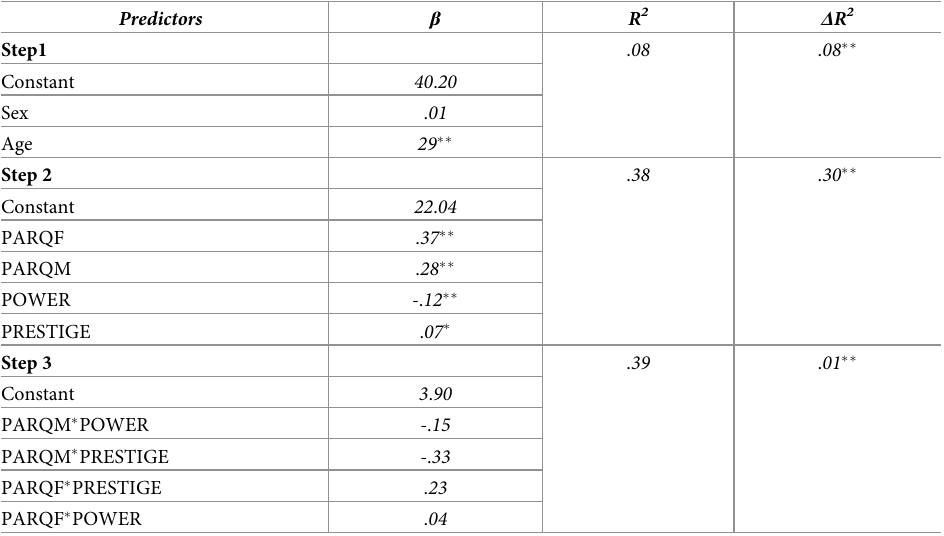
Table 2. Hierarchical regression analyses predicting children´s psychological maladjustment adjusted by sex and